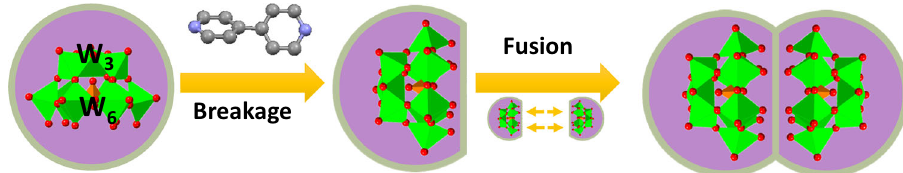
Fig. 5 Proposed breakage-fusion conversion mechanism from SD/Ag51b to SD/Ag72a. The green shell represents silver shell.